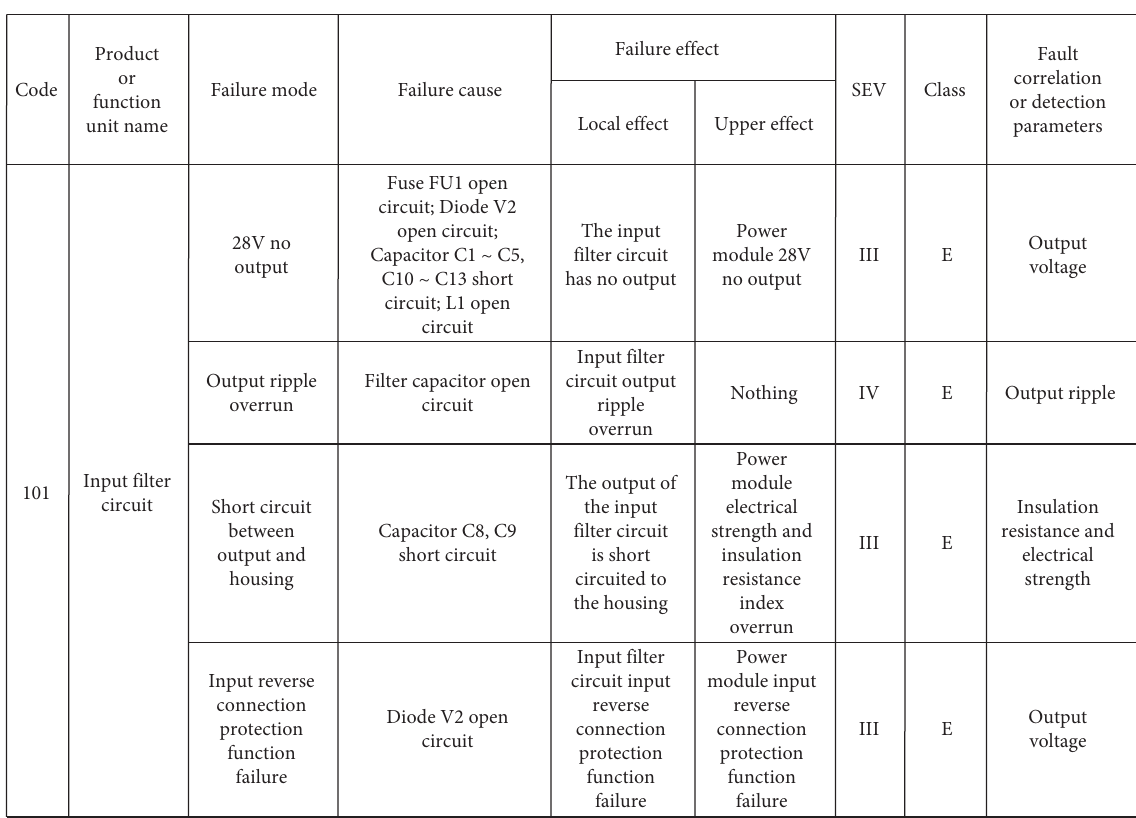
Figure 10: The screenshot of FMEA.